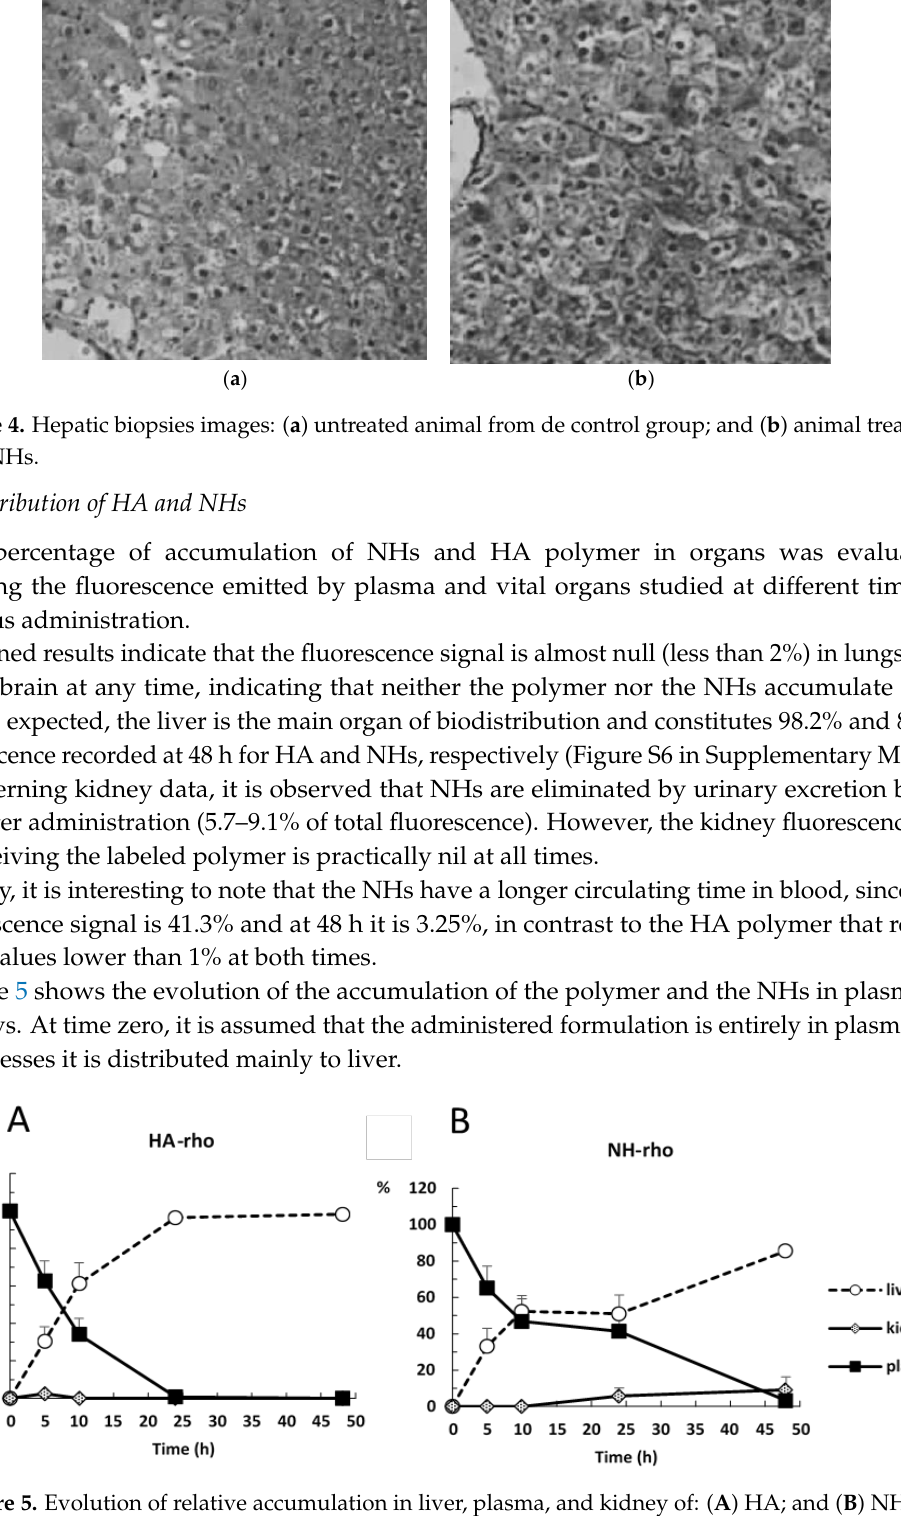
Figure 5. Evolution of relative accumulation in liver, plasma, and kidney of: ( A ) HA; and ( B ) NHs.